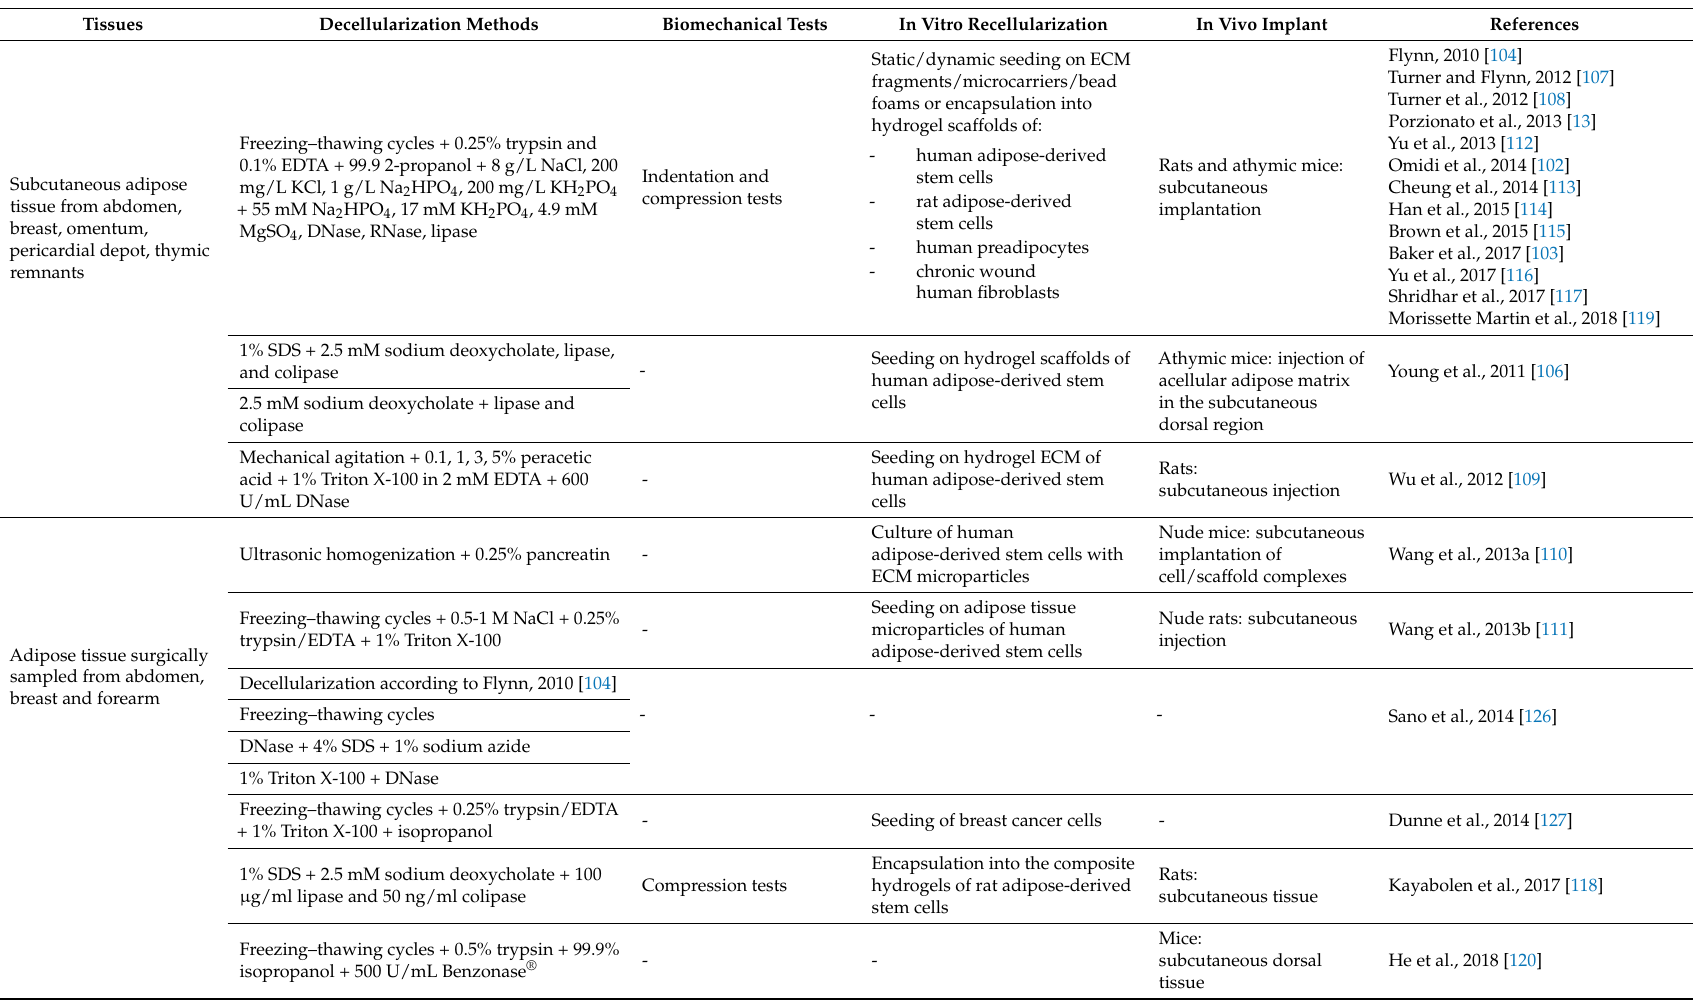
Table 3. Adipose tissues. Decellularization techniques, biomechanical tests, recellularization methods, and in vivo implant of adipose extracellular